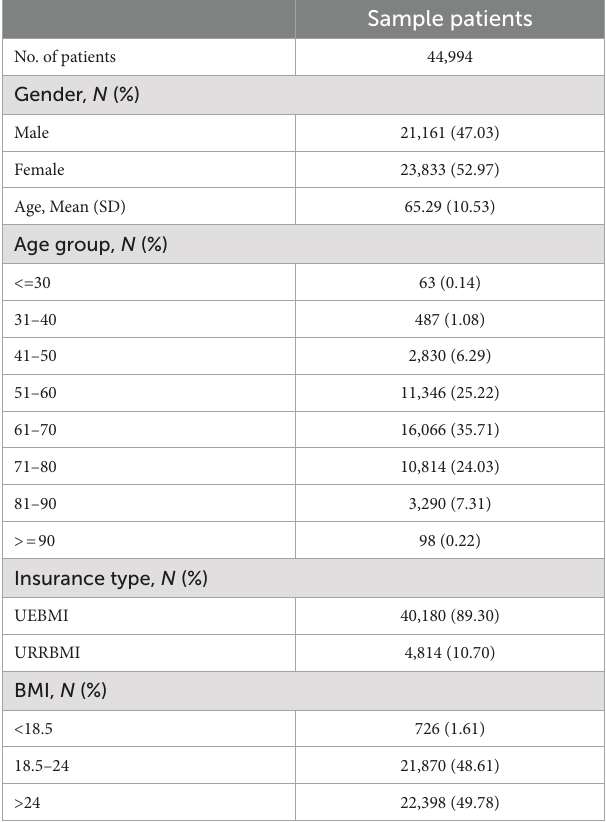
TABLE 1 Demographic information of sampled patients in